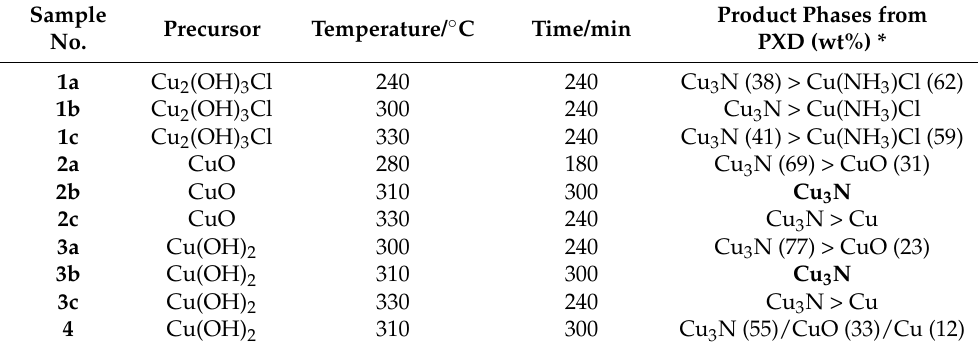
Table 1. Experimental conditions for samples prepared by ammonolysis